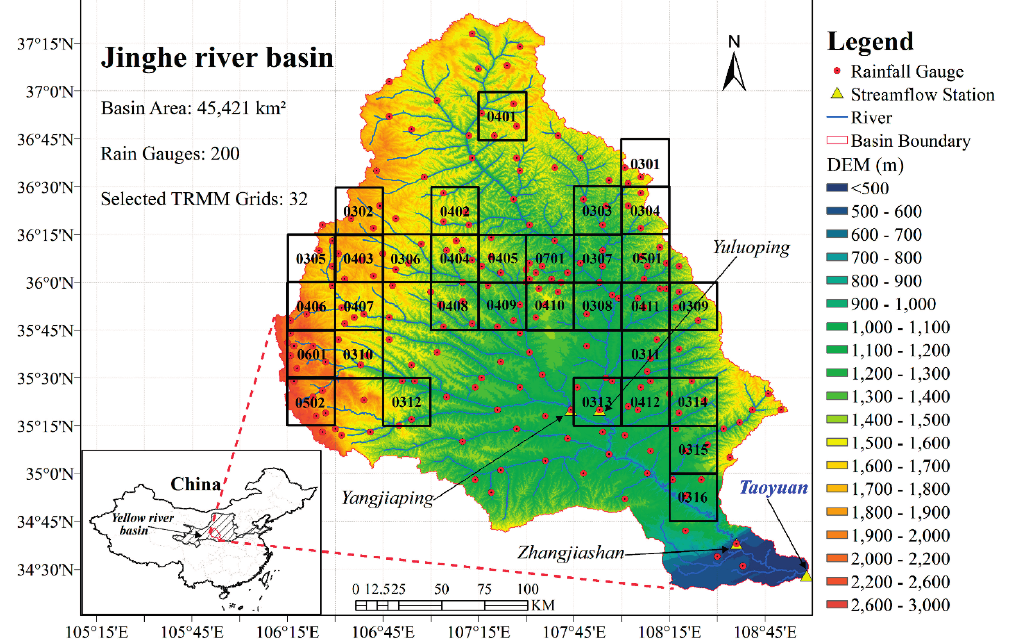
Figure 1. Map of the Jinghe river basin, rain gauges, streamflow stations, topography, and sampling strategies used in this study. Black squares represent the 32 selected 0.25° × 0.25° grids for precipitation comparison. Numbers are grid IDs (e.g., 0301 indicates the first grid containing three gauges and 0302 represents the second grid containing three gauges and so